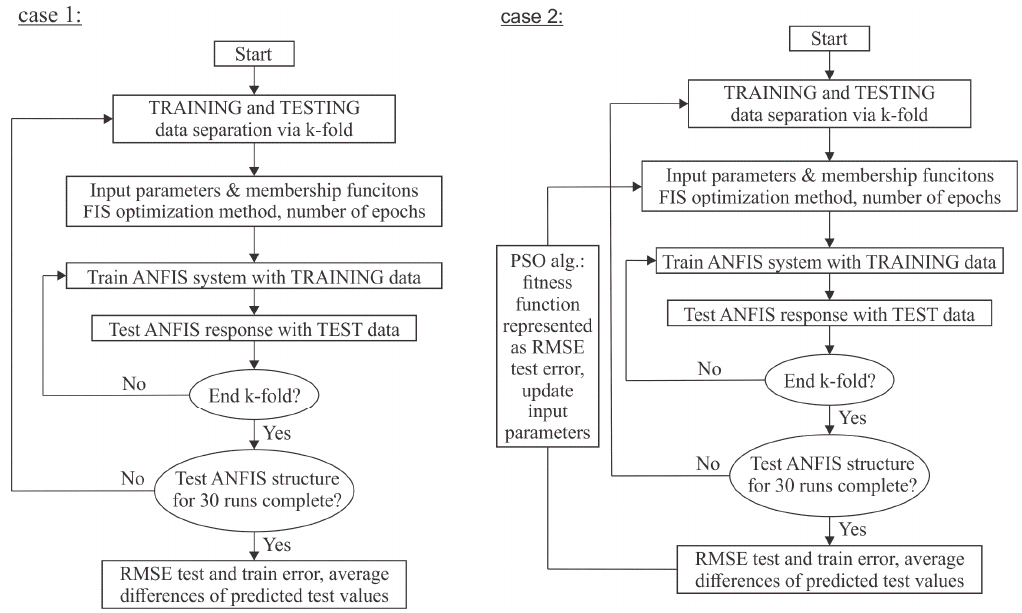
Figure 5. Case 1 and case 2 flowchart representations.